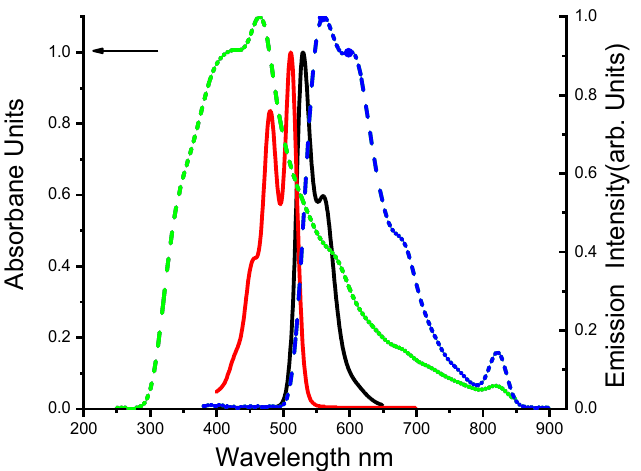
Figure 1. Normalized electronic absorption spectra and fluorescence spectra of 1.41 × 10 − 5 M DBDMA in dimethylformamide at 25 °C. The lines represent ـــــــــ absorption and ــــــــ fluorescence spectra in the solution state, and the dotted lines represent ــ ـ ـ absorption and ـ ـ - ـ fluorescence spectra in photosol-gel media, respectively ( λ ex = at λ ab max ).